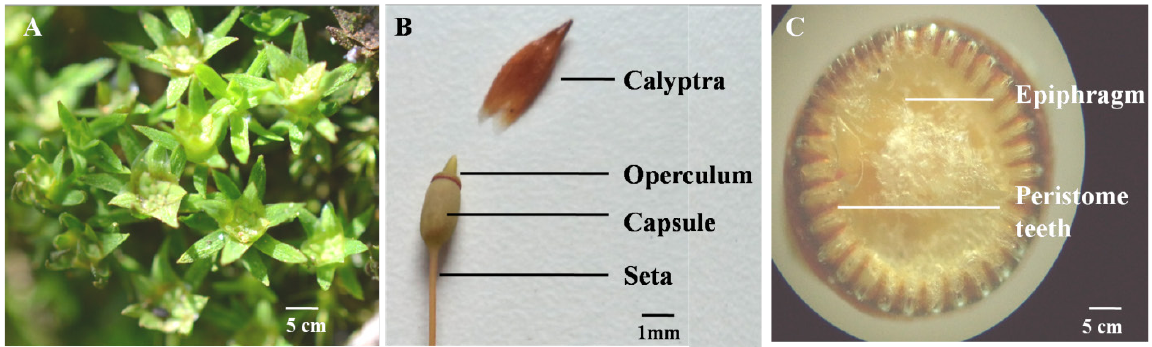
Figure 1: Vegetative characters of Polytrichaceae (A) transverse section of the stem of Pogonatum subtortile (B) transverse section of upper vegetative leaf of P. aloides (C) upper vegetative leaf of P. microstomum.